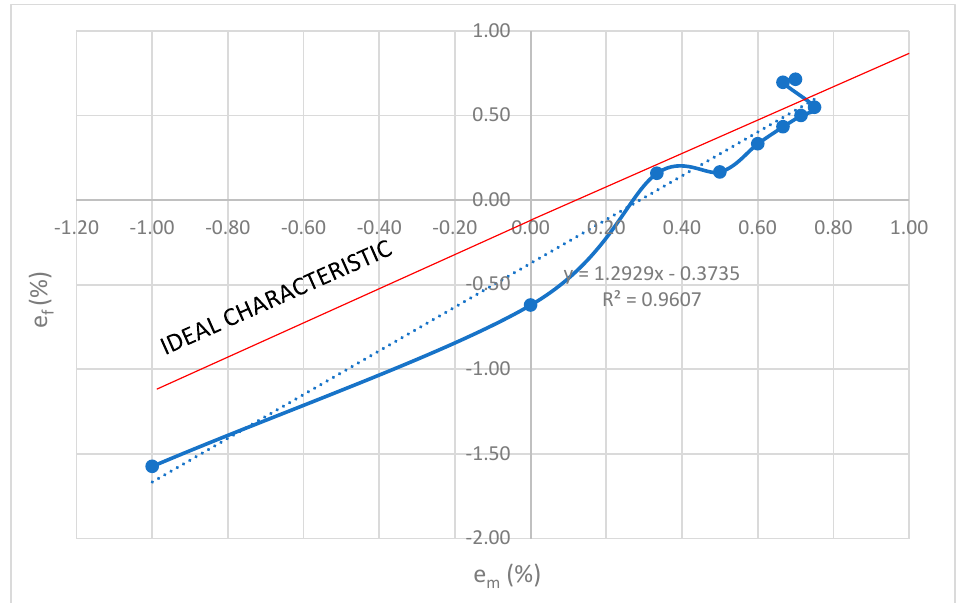
Figure 2. Interpolation “spline” curve in statistical experiment.